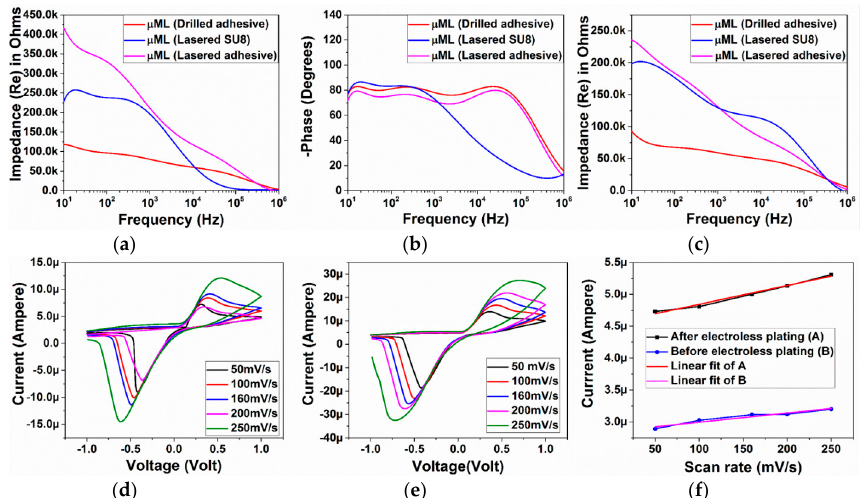
Figure 11. ( a ) EDS measurements confirm the presence of platinum and the coverage on the surface is observed to increase from 7% wt. to 31% wt. and finally to almost 95% wt. after 1 h, 3 h and 6 h of electroless deposition respectively; ( b ) SEM analysis of the electrodes showing micro-porous platinum deposited on the silver paste electrodes after 6 h of electroless deposition.